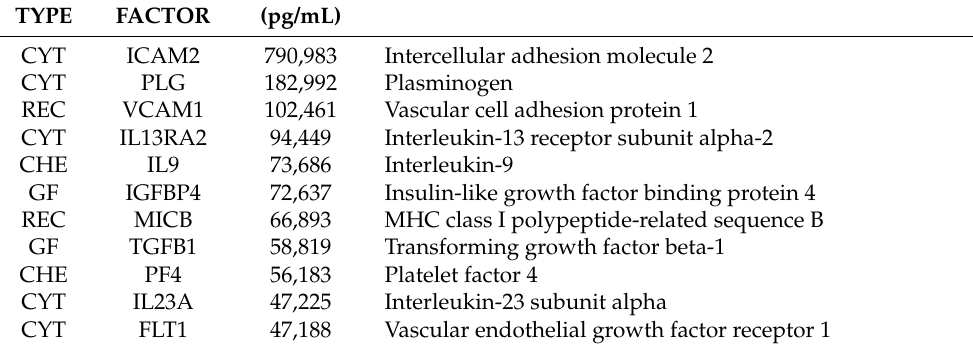
Table 1. Most abundant soluble factors in pooled activated